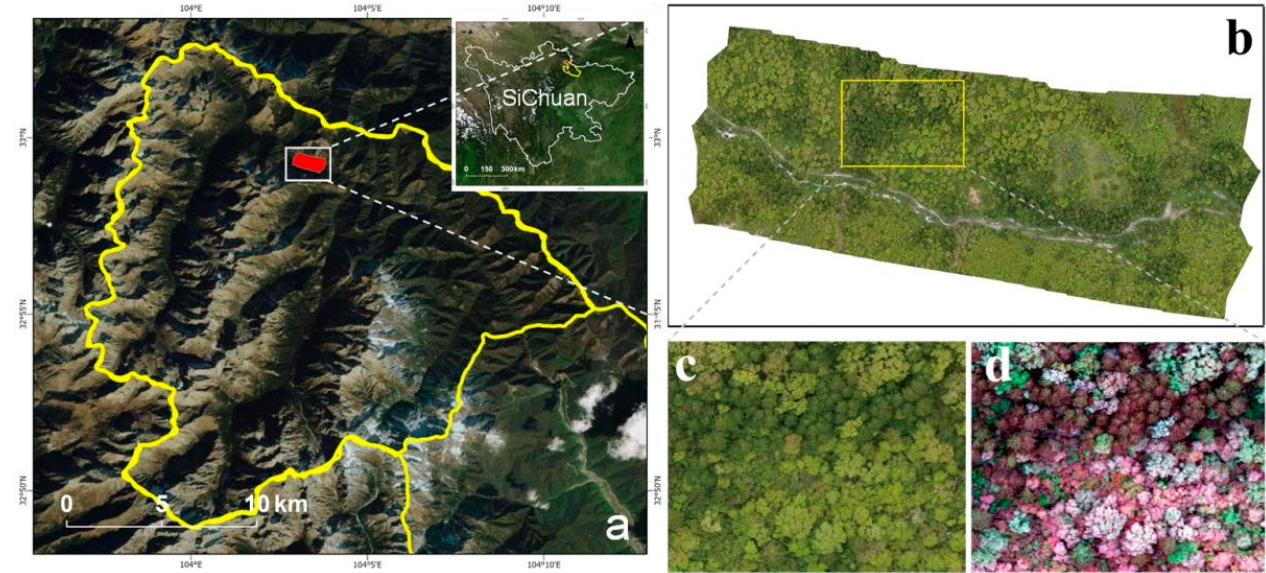
Figure 1. Overview of the study area: ( a ) satellite Image of the study area; ( b ) June data collection in the study area; ( c ) a subarea of Red–green–blue (RGB) imagery in June; and ( d ) a false color composite (green-red-near infrared) of the subarea of the multispectral imagery in June.